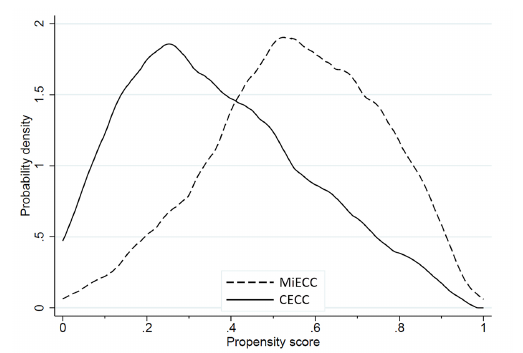
Figure 2: Kernel density analysis of the probability to receive MiECC in either group shows a good overlap of the groups. Re- gions outside the more centred 2.5th and 97.5th percentile (red vertical lines) were trimmed off to eliminate residual